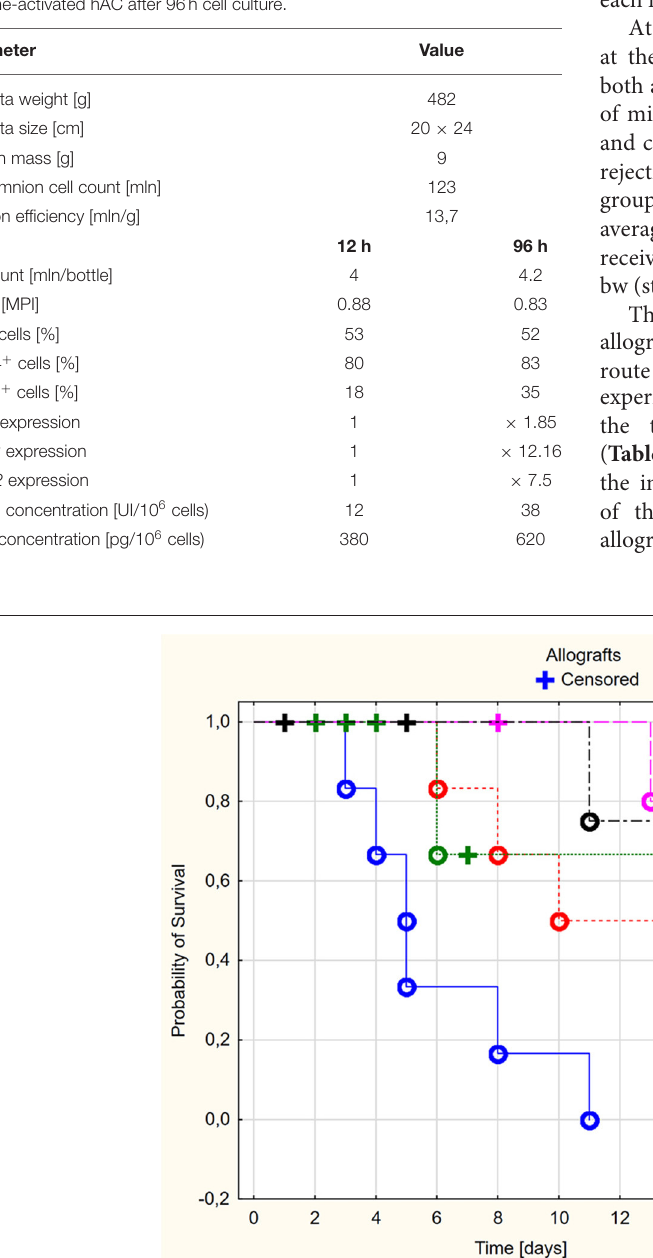
Frontiers in Medicine |